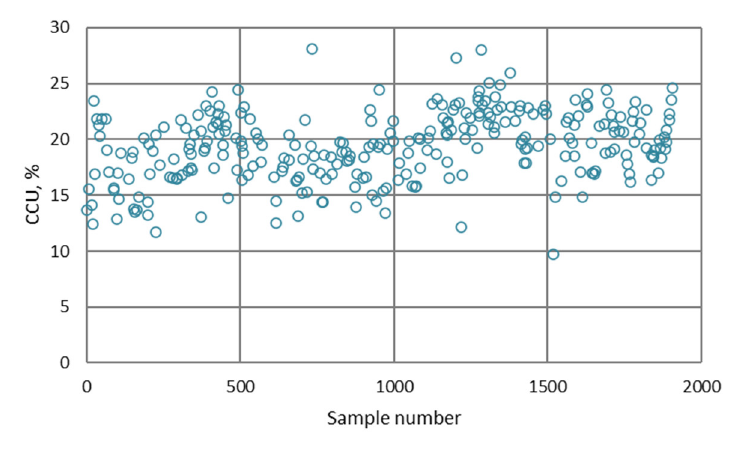
Figure A28. NN1 model—testing dataset.